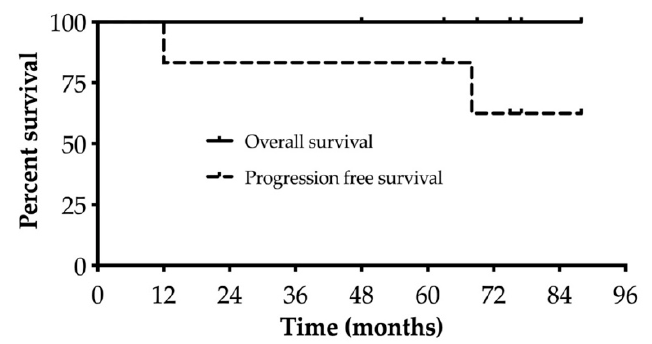
Figure 2. Survival